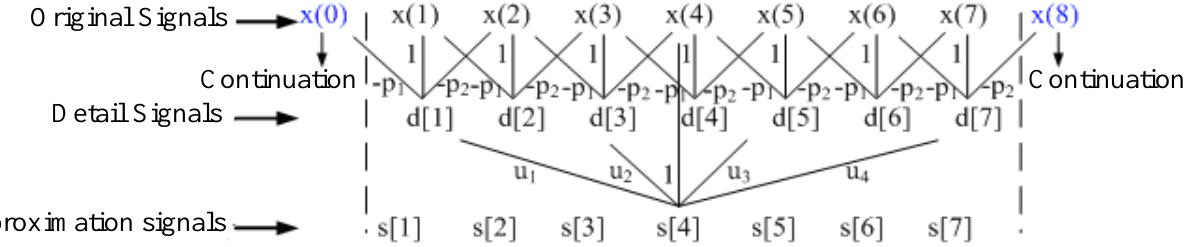
Figure 2. The decomposition process of redundant second generation wavelet.